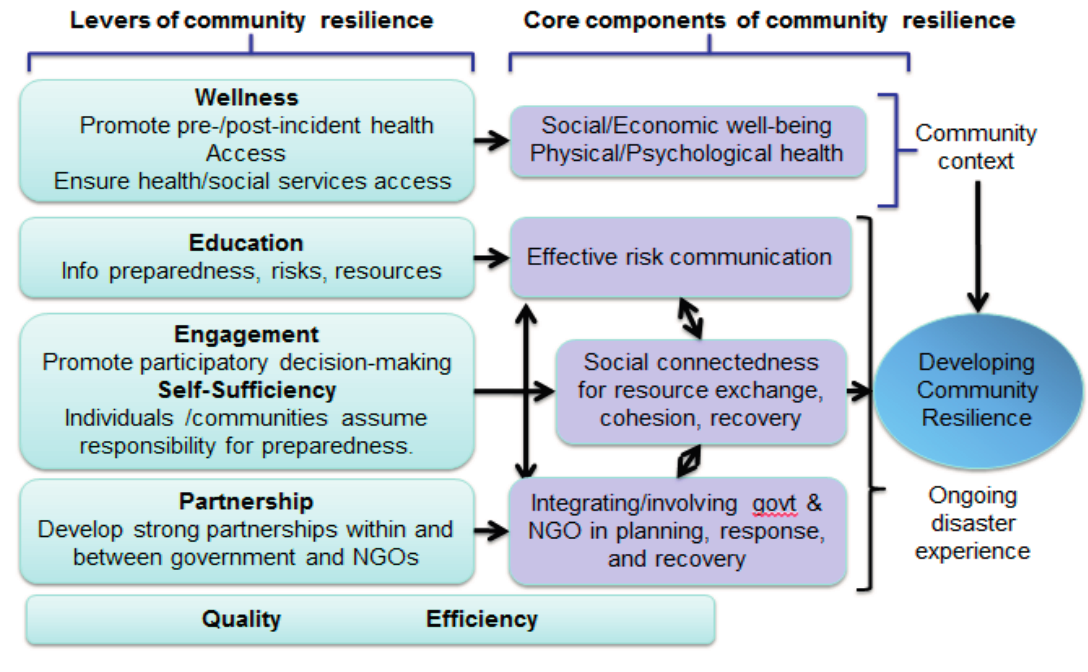
Figure 1. Conceptual Framework for LACCDR (reprinted with permission from Chandra et al. 2013)